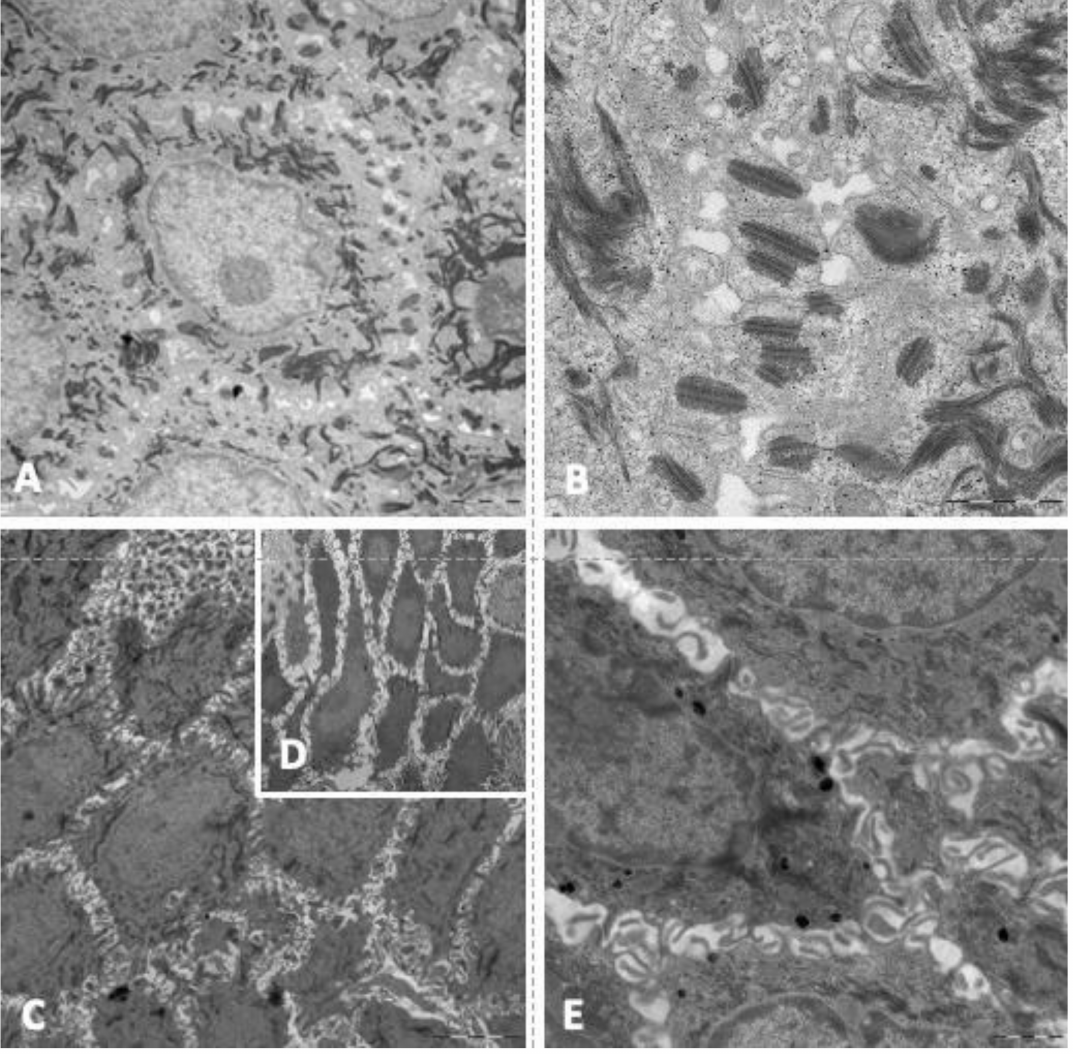
Figure 3. Main findings in the electron microscope study. ( A ): keratinocytes of the spinous layer with abundant keratin filaments in cytoplasm. ( B ): keratinocytes with normal ultrastructural features (electron-dense midline, inner plaques and keratin filament junctions). ( C ): enlargement of the intercellular space between keratinocytes. ( D ): increase in the length of the cytoplasmic bridges. ( E ): Keratinocytes with unaffected